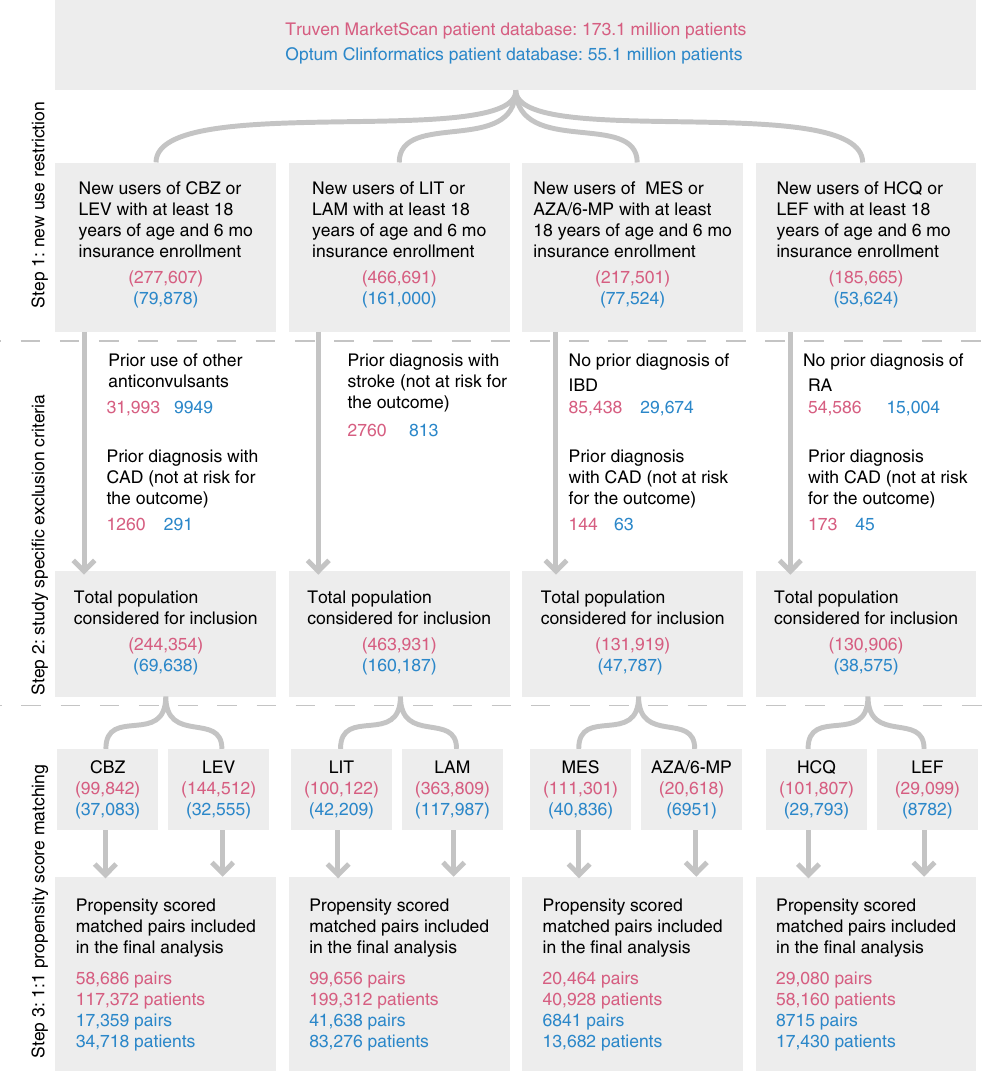
Fig. 2 Flow-chart of the pharmacoepidemiologic investigations using Truven MarketScan and Optum Clinformatics patient databases. AZA azathioprine, 6-MP 6-mercaptopurine, CBZ carbamazepine, HCQ hydroxychloroquine, IBD in fl ammatory bowel disease, LAM lamotrigine, LEF le fl unomide, LEV levetiracetam, LIT lithium, MES mesalamine, RA rheumatoid arthritis. The balance achieved in patient characteristics and outcome risk factors between